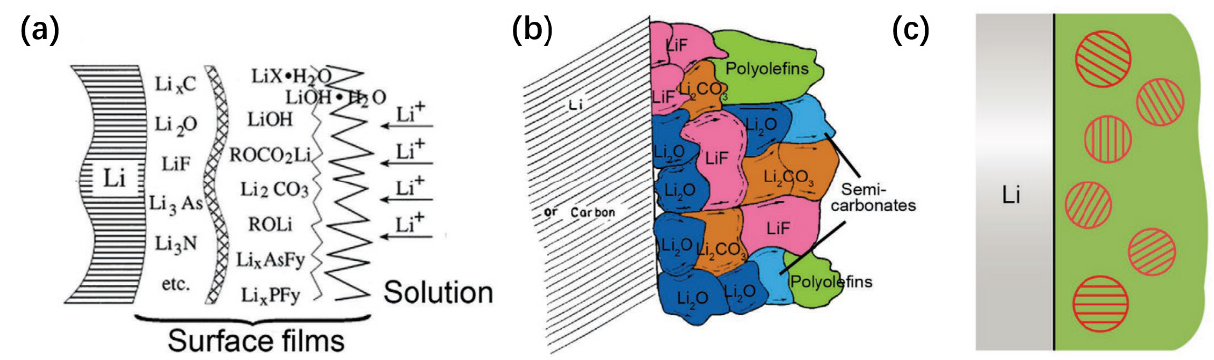
Figure 6. SEI model: ( a ) Multilayer model [71]; ( b ) Mosaic model [72]; ( c ) Raisin pudding model